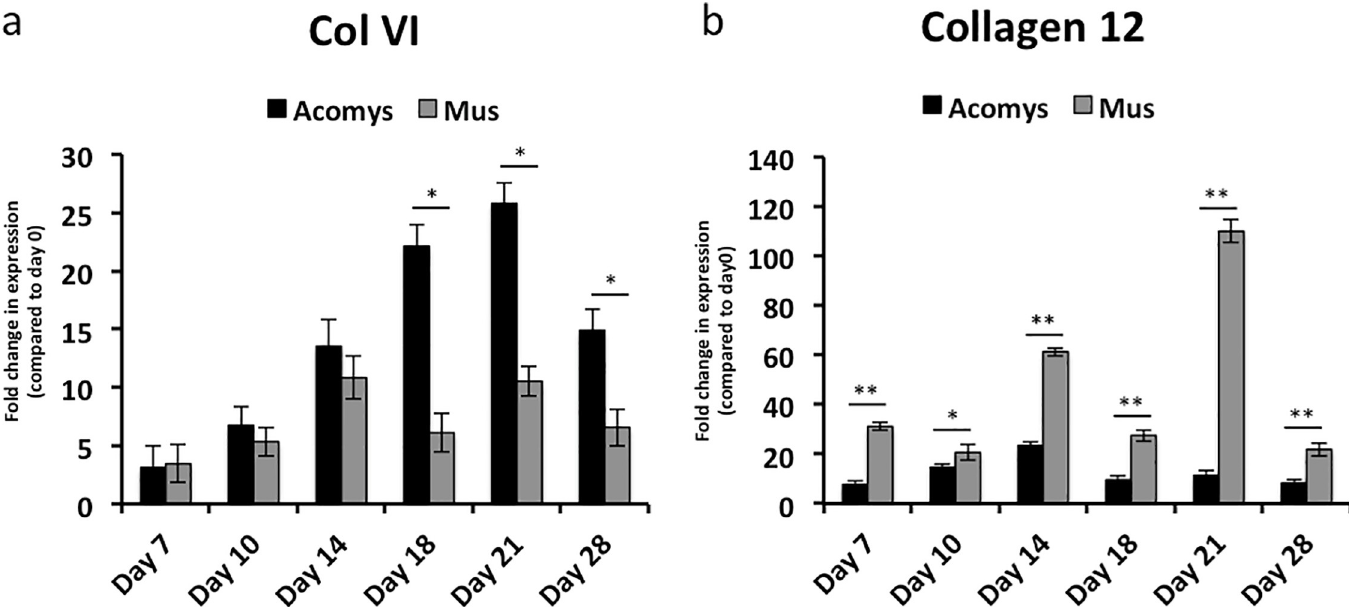
Fig 6. Differential expression of key collagens during wound healing between A . cahirinus and M . musculus . RT-qPCR analyses were performed for ( a ) Col6a1 and ( b ) Col12a1 . All labels, symbols and calculations are as described in Fig 3 . Black bars represent A . cahirinus and grey bars represent M . musculus data. All fold changes are statistically significant (p-value � 0.05) as compared to each species normal skin day 0 sample. Asterisk over horizontal line indicates statistical significance between species for that time